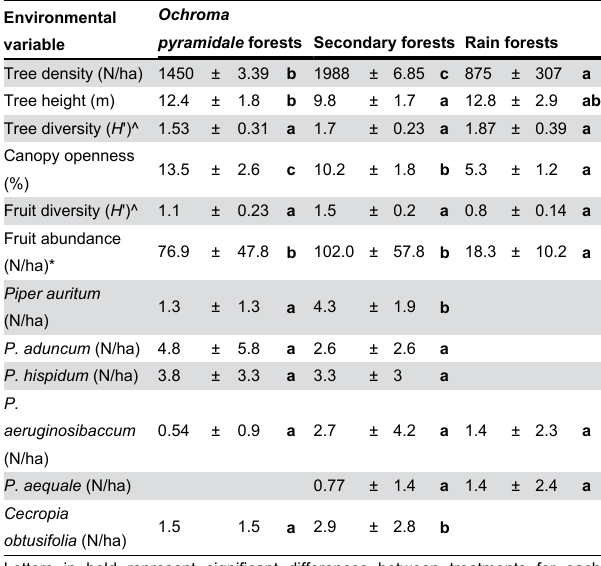
Letters in bold represent significant differences between treatments for each vegetation structure variable based on ANOVA and post hoc Tukey test (*), or Kruskal-Wallis and post hoc Mann-Whitney U test with Bonferroni correction and a Hutcheson two-tailed t-test (^). The difference in fruit availability of species only present in two forest types ( Piper auritum , P. aduncum , P. hispidum and Cecropia obtusifolia ) was tested with a Mann-Whitney U